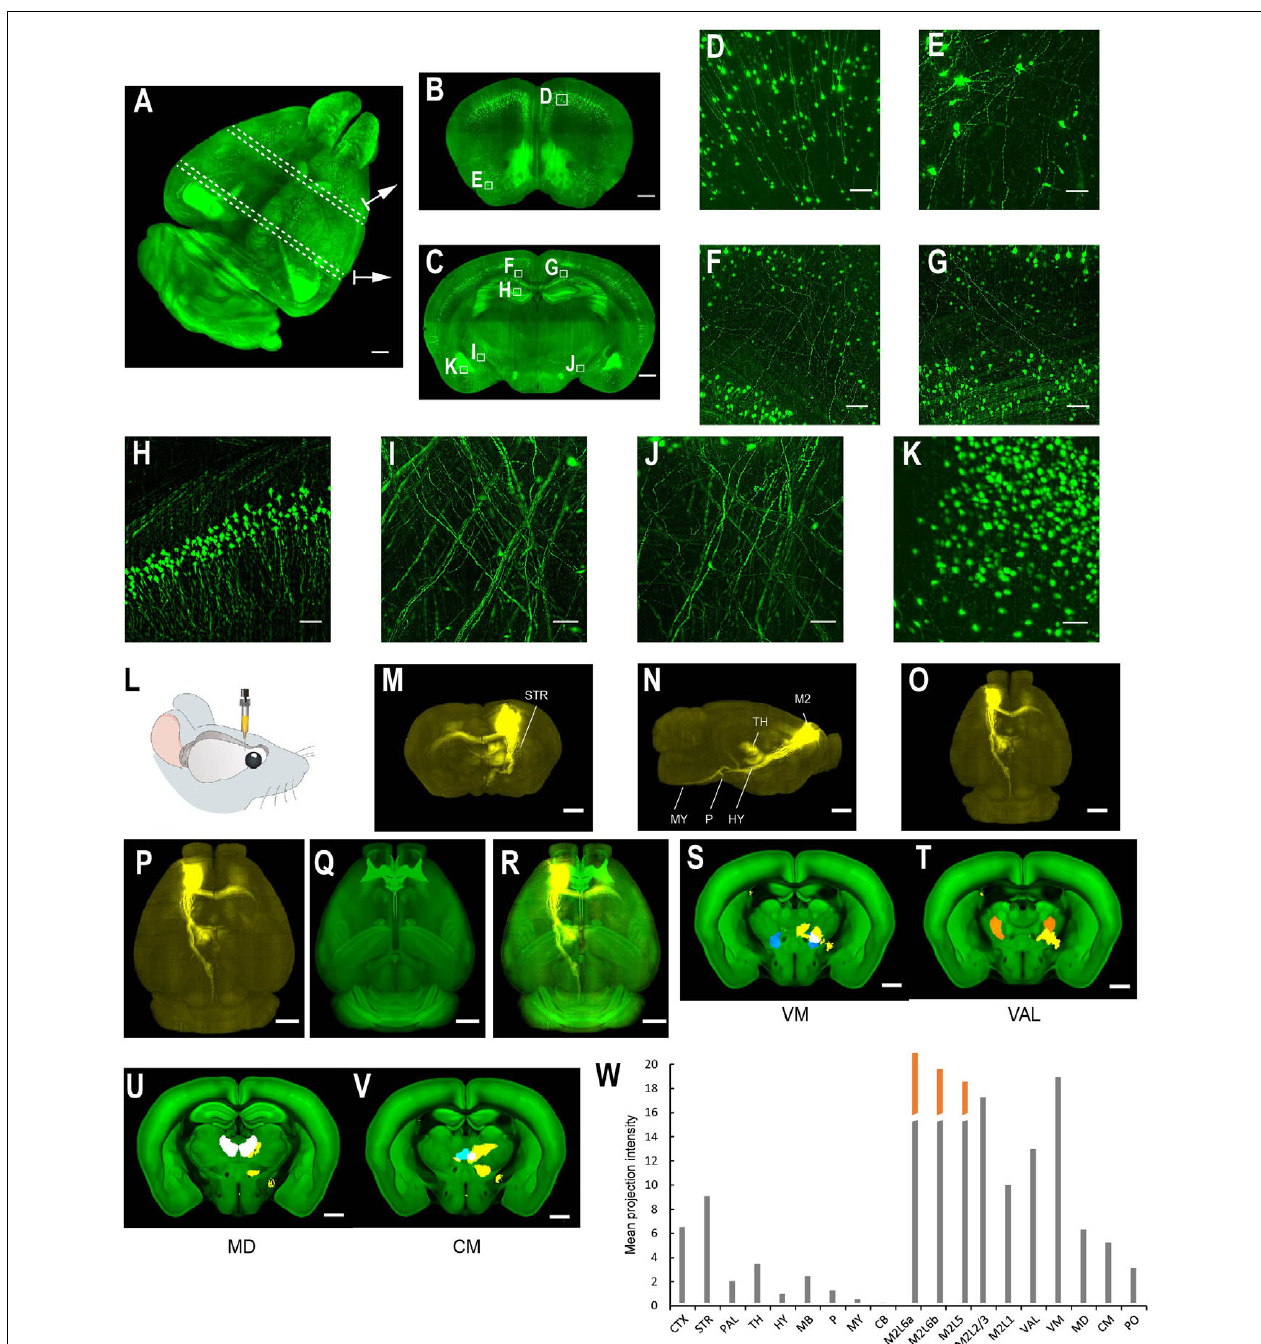
FIGURE 6 | Whole brain imaging of uDISCO-cleared Thy1-YFP-H transgenic mouse brains and EGFP virus injected brains. (A–K) Thy1-YFP-H transgenic mouse brains cleared using uDISCO and imaged with the mLSFM setup. (A) 3D rendering of images of a uDISCO-cleared brain. Arrows point to example sections. Similar results in the n = 5 samples. (B,C) MIPs of 1-mm thick coronal sections at positions indicated in (A) . (D,E) Zoomed-in view of the boxed regions in (B) . (F–K) Zoomed-in view of the boxed regions in (C) . (L–W) Whole brain imaging of bulk injected brain (cleared using uDISCO protocol) reveals axonal projections of ALM neurons in different cortical and subcortical areas. (L) Schematic of viral injection of AAV2/1-CAG-tdTomato in ALM (AP 2.5, ML 1.5, DV 0.8). (M–O) Coronal, sagittal, and horizontal MIPs of a uDISCO-cleared mouse brain with several labeled areas indicated. (P) The brain is registered to the Allen common reference brain. (Q) Corresponding Allen reference brain. (R) Merged image of (P,Q) . (S–V) Fluorescence signals (yellow) in various thalamic nuclei, including VM, VAL, MD, and CM. Nuclei are color-coded: VM, blue; VAL, orange; MD, white; CM, cyan. (W) Mean projection intensity approximated by fluorescence value in brain regions in the ipsilateral hemisphere. Orange bar, contribution from the injection site. CTX, cerebral cortex; STR, striatum; PAL, pallidum; TH, thalamus; HY, hypothalamus; MB, midbrain; P, pons; MY, medulla; CB, cerebellum; M2, secondary motor area; VAL, ventral anterior-lateral complex of the thalamus; VM, ventral media nucleus of the thalamus; MD, mediodorsal nucleus of the thalamus; CM, central medial nucleus of the thalamus; PO, posterior complex of the thalamus. Scale bars, 1 mm (A–C,M–V) , 50 µ m (D) , 100 µ m (E–K) .